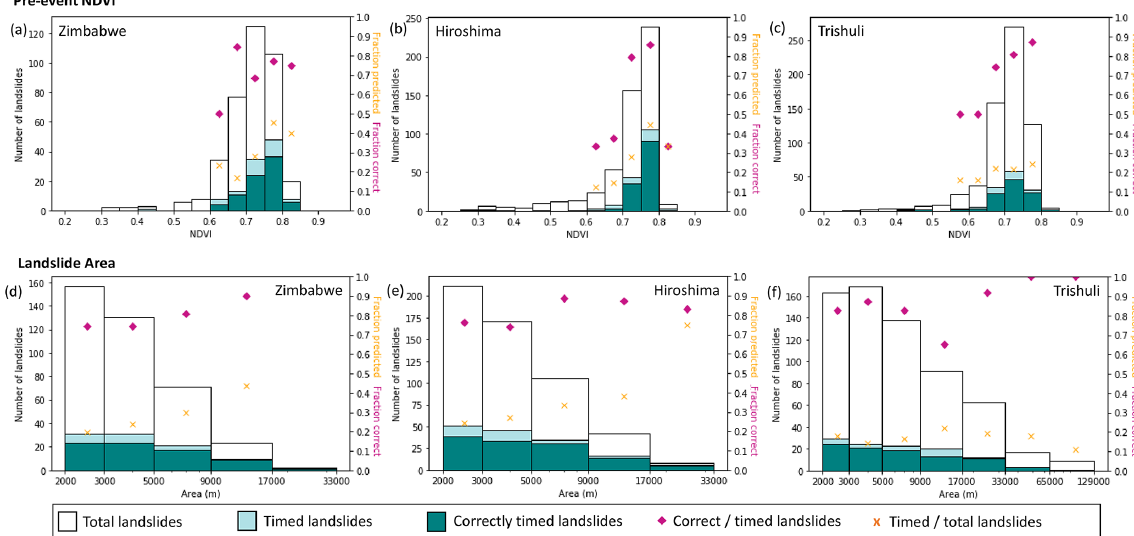
Figure 5. The distribution of total landslides (white), landslides assigned a time (light green) and landslides assigned the correct time (dark green) for different values of pre-event NDVI (greenest value in the year preceding the event) (a–c) and landslide area (d–f) . Predictions were obtained from combining ascending and descending track SAR (Sect.